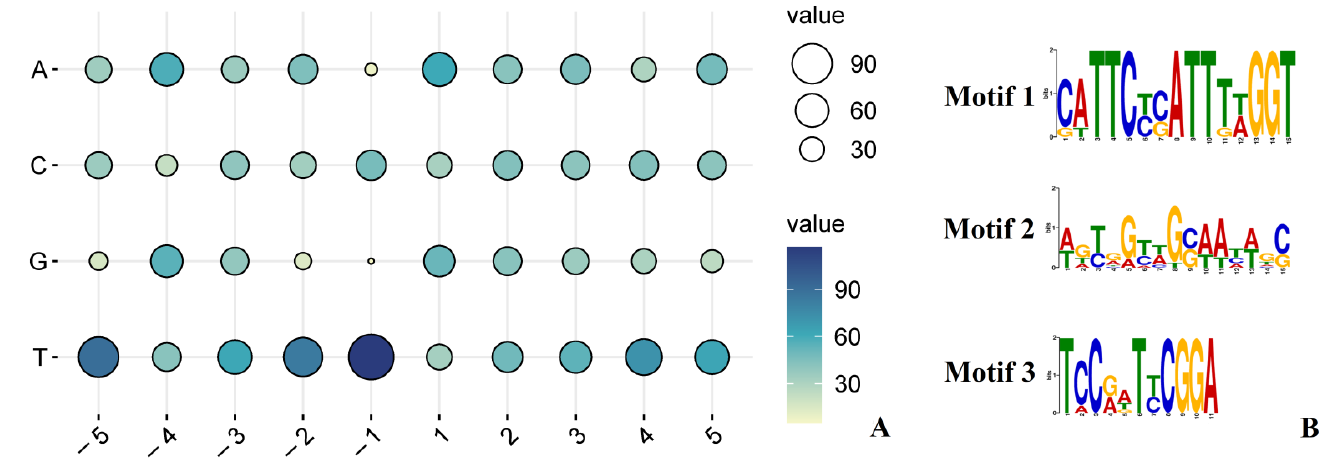
Figure 3. Features of sequences around RNA editing sites. ( A ) The base preference around edited C. A, C, G and T are abbreviation for nucleotide. The numbers represent the flanking base positions of the edited Cs. ( B ) Conserved motifs around RNA editing sites. The horizontal axis is the base position in the corresponding motif. The vertical axis is the fraction of bits per